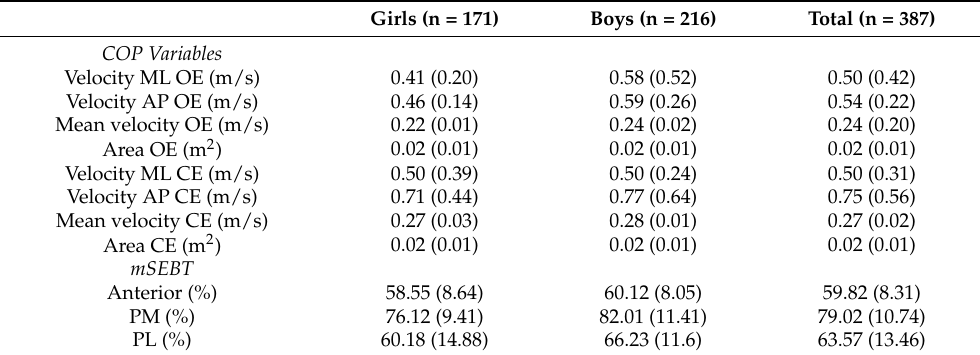
Table 2. Results of the static (center of pressure variables) and dynamic (performance in mSEBT) postural balance tests (mean and standard deviations).